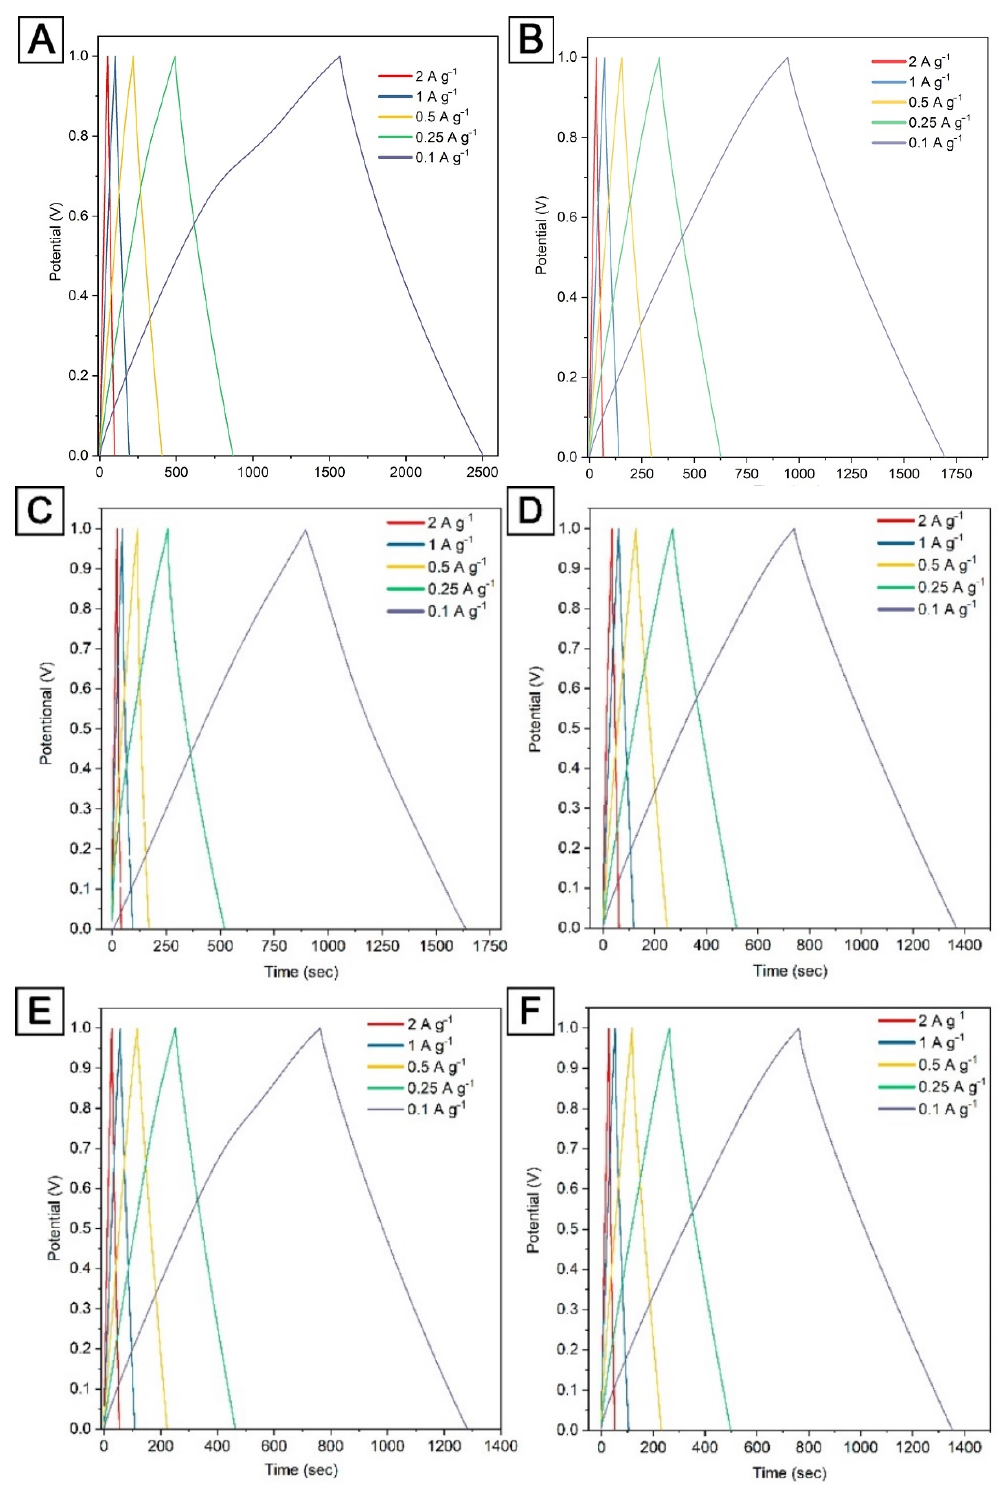
Figure 5. Curves of galvanostatic charge–discharge at different current densities (0.1, 0.25, 0.5, 1.0, 2.0 A g − 1 ) for electrodes based on ( A ) AKS-700, ( B ) APS-700, ( C ) AKS-800, ( D ) APS-800, ( E ) AKS-900 and ( F ) APS-900 with 6 M KOH electrolyte.